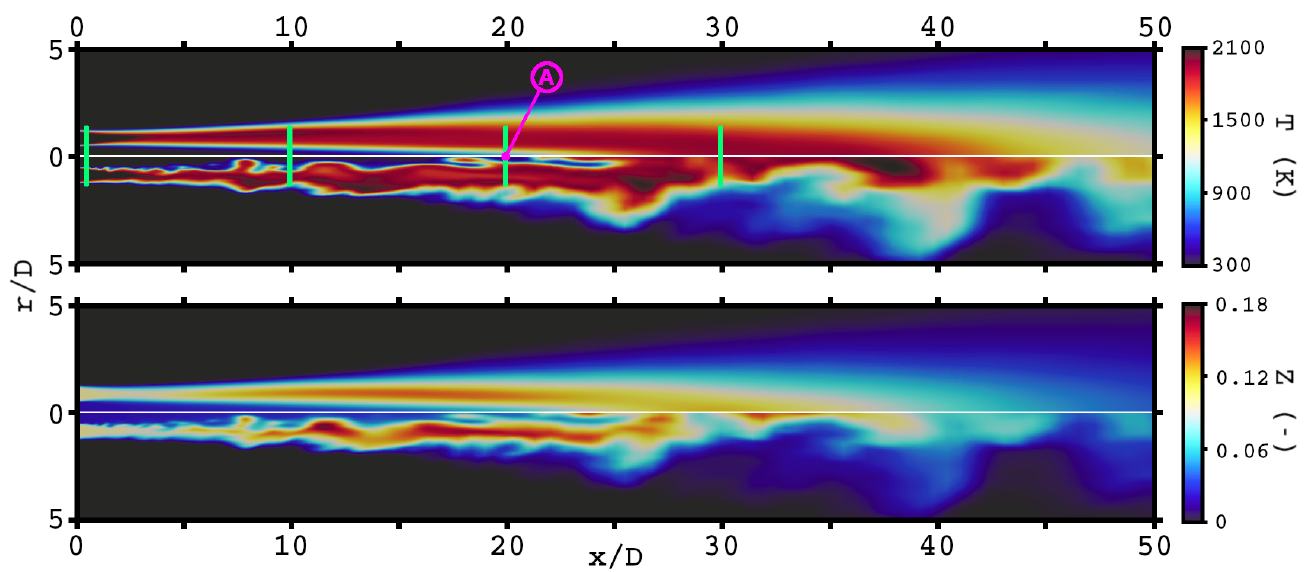
Figure 2. Temporal average (upper part) and instantaneous contours (lower part) of both the Favre-filtered Probability Density Function FDF-integrated temperature ( top ) and first moment of the mixture fraction FDF ( bottom ) for the Eulerian Stochastic Fields (ESF16) simulation. The vertical green bars denote axial positions at which simulation data are compared with experiments. The magenta-colored point exhibits the position of probe A, for which time-series analyses are performed in a later